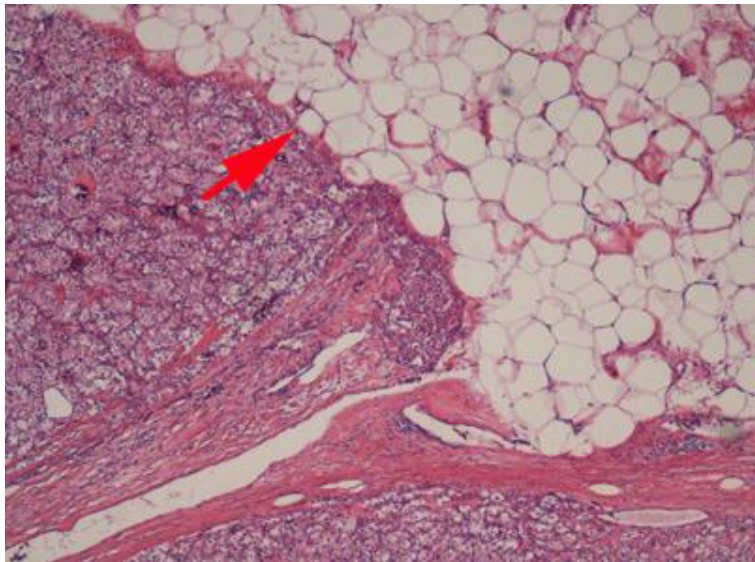
Figure 2A. Carcinoma in contact with renal sinus fat indicates renal sinus